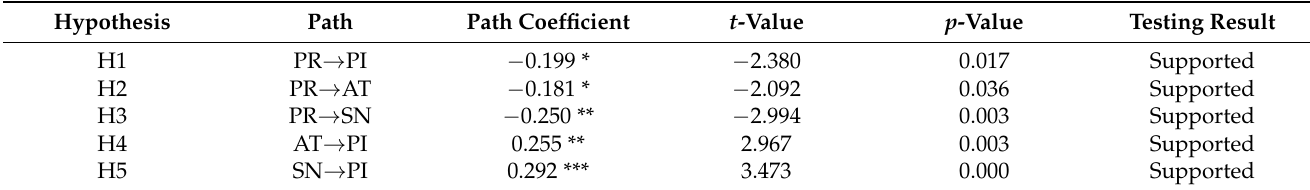
Table 6. The results of hypothesis